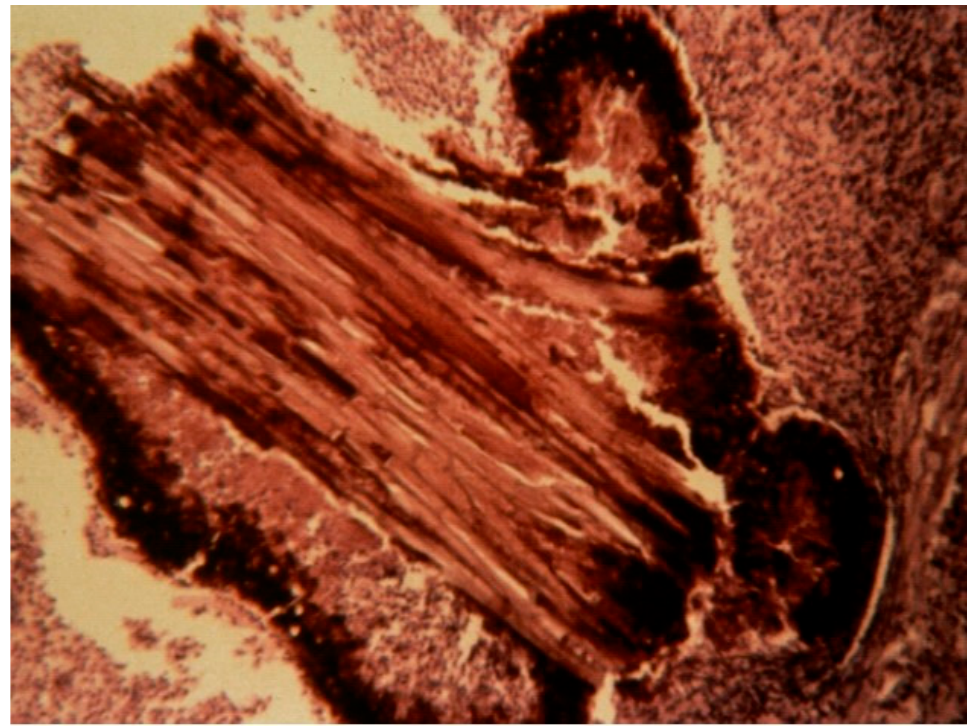
Figure 2. Thorn in a Falcimosporma sp. grain (R. Camain, Dakar).